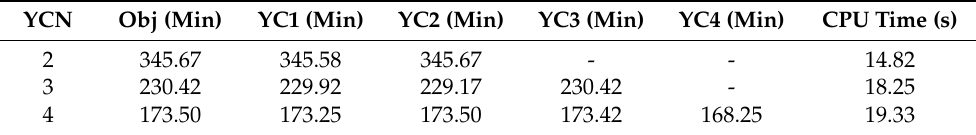
Table 4. Comparison of experimental results.